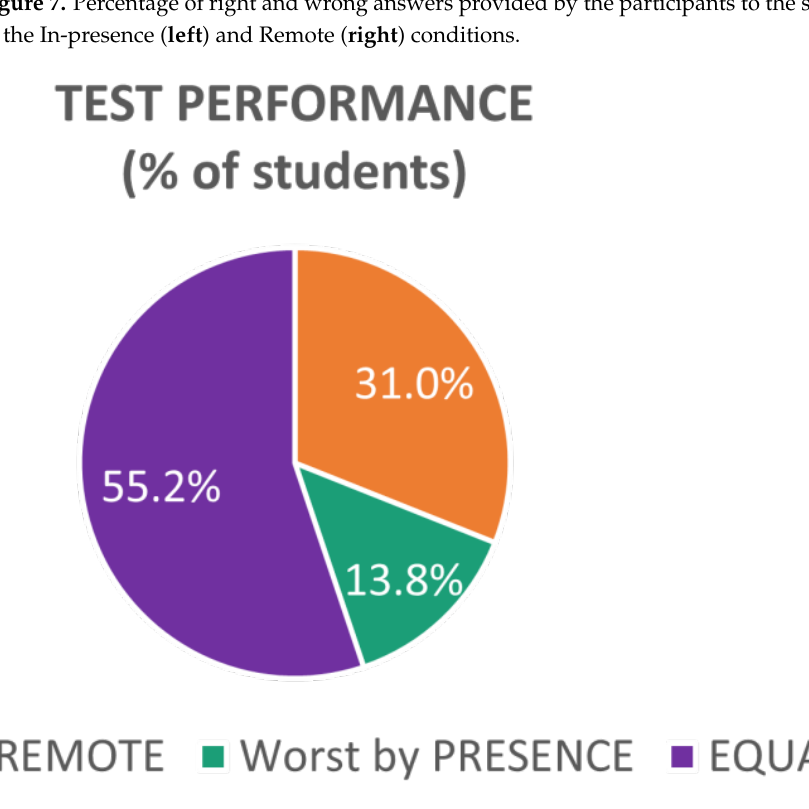
Figure 8. Percentage of students divided according to their test performance: in orange, students who gave more wrong answers in the Remote condition; in green, students who gave more wrong answers in the Presence condition; in violet, students who had the same number of errors between the two